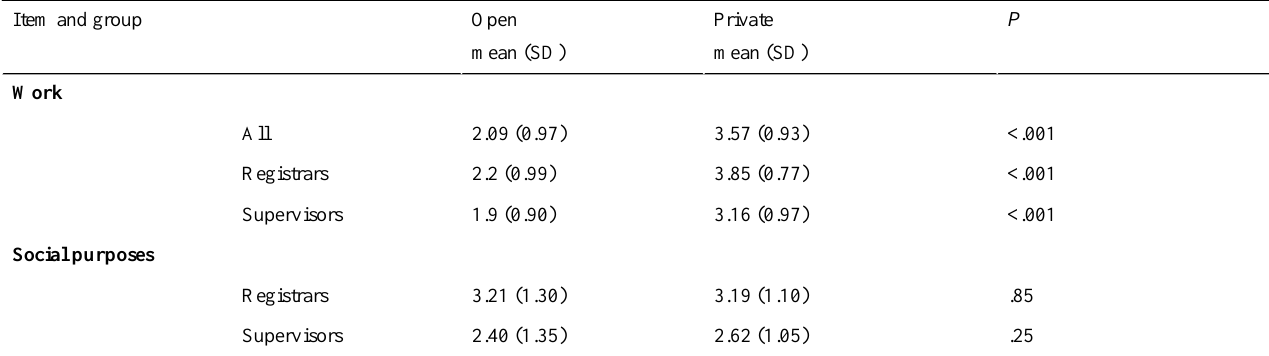
Table 5. Private versus open network usage among registrars and supervisors.